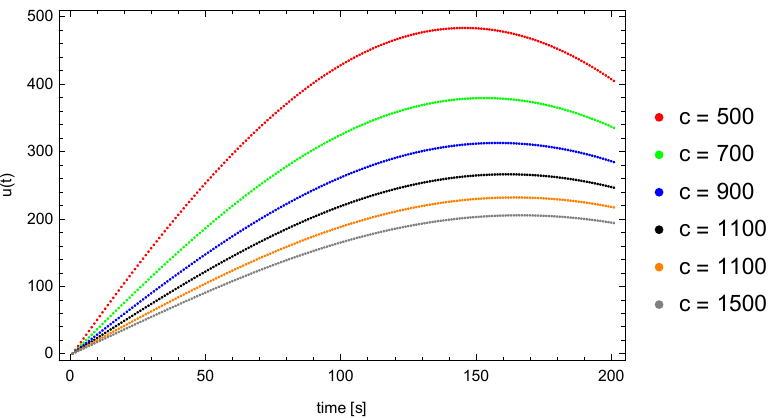
Figure 10. Values of the function u at point K 4 for different values of the parameter c ( β = 0.6, α =